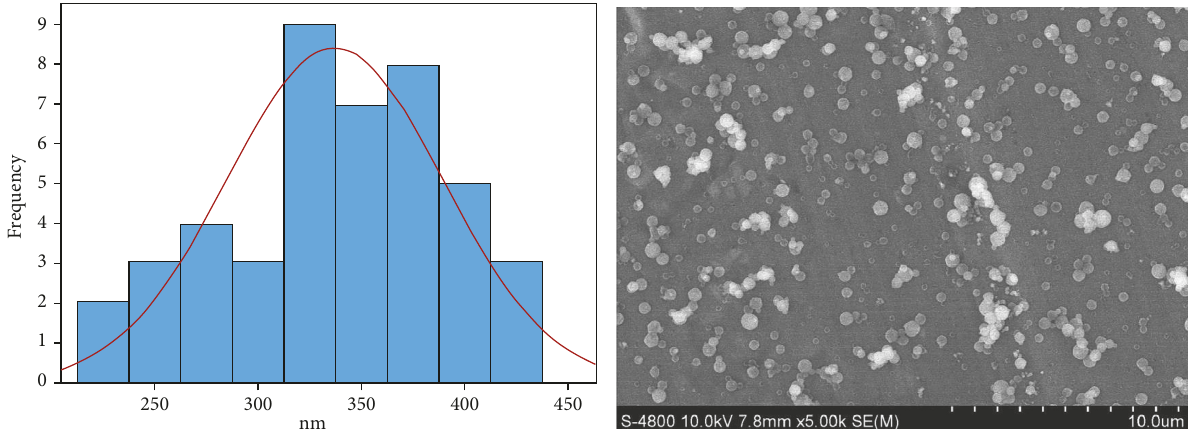
Figure 13: The size distribution and SEM image of 1.5 wt.% M3 chitosan concentration in acetic acid concentration of 90 wt.% at U L 10cm. (cid:30)